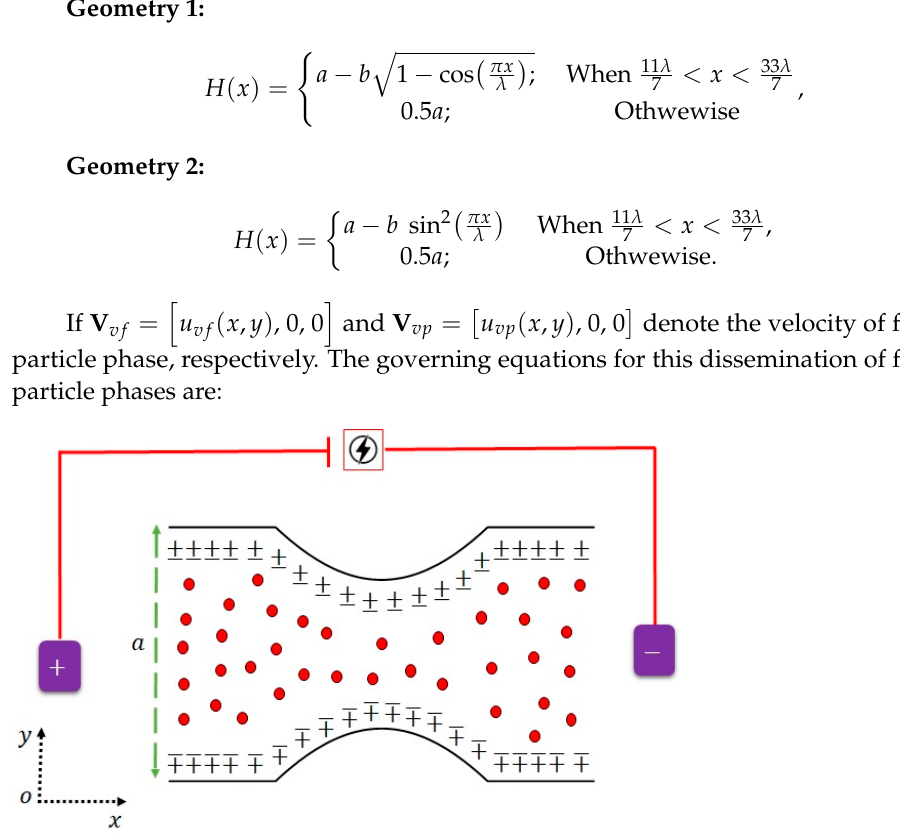
Figure 1. Convergent geometry.